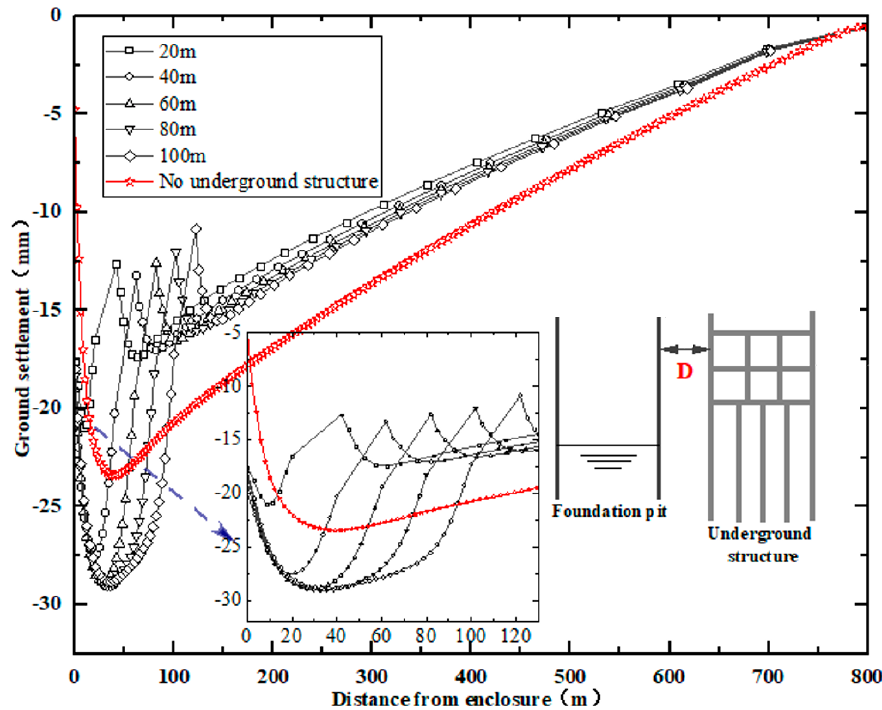
Figure 6. Distribution of ground settlement under different D .